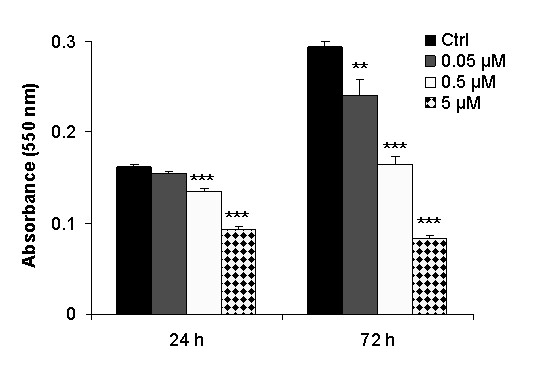
Cytotoxicity of lapatinib in A549 cells exposed to different concentrations (0.05, 0.5 and 5 μM) of the drug, for 24 h and 72 h. At the indicated time point, cell viability was measured by MTT, indicating that lapatinib significantly reduces A549 cell proliferation (**: P < 0.01; ***:P < 0.001).